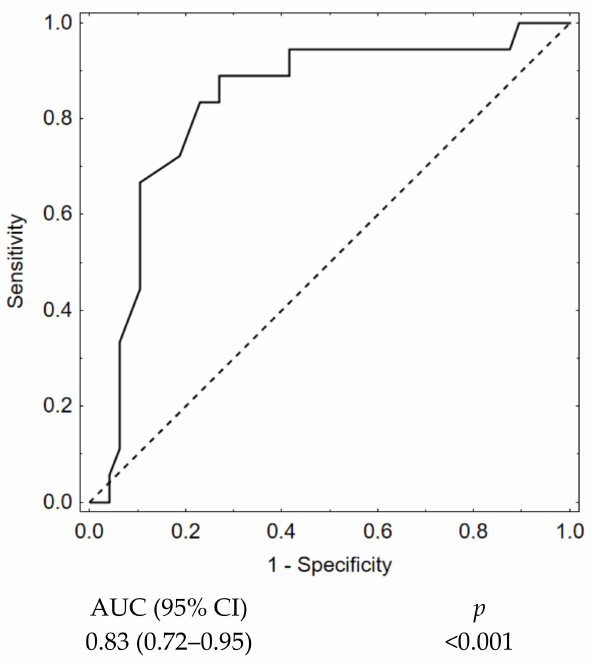
Figure 5. Aneurysm neck size ROC curve.